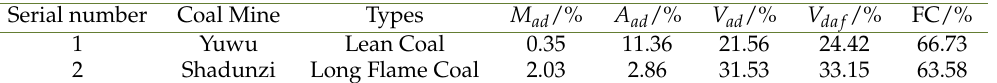
Table 1. Proximate analysis of coal